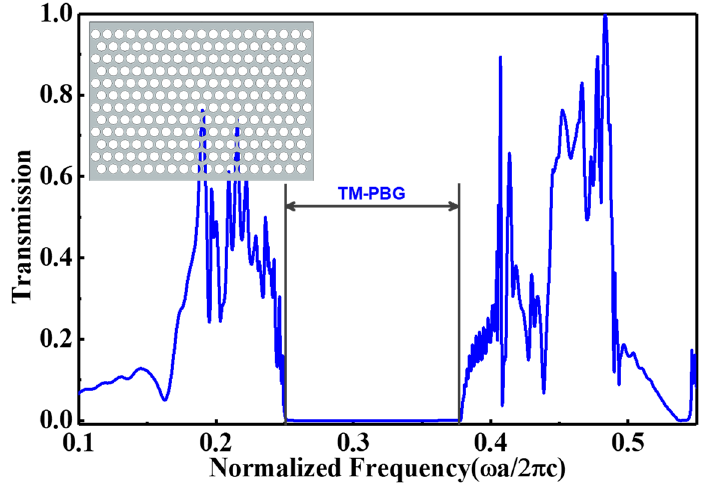
Figure 2. The transmission spectrum of the basic E-PhC slab of 𝑛 = 3.48 and 𝑅 = 0.45𝑎.